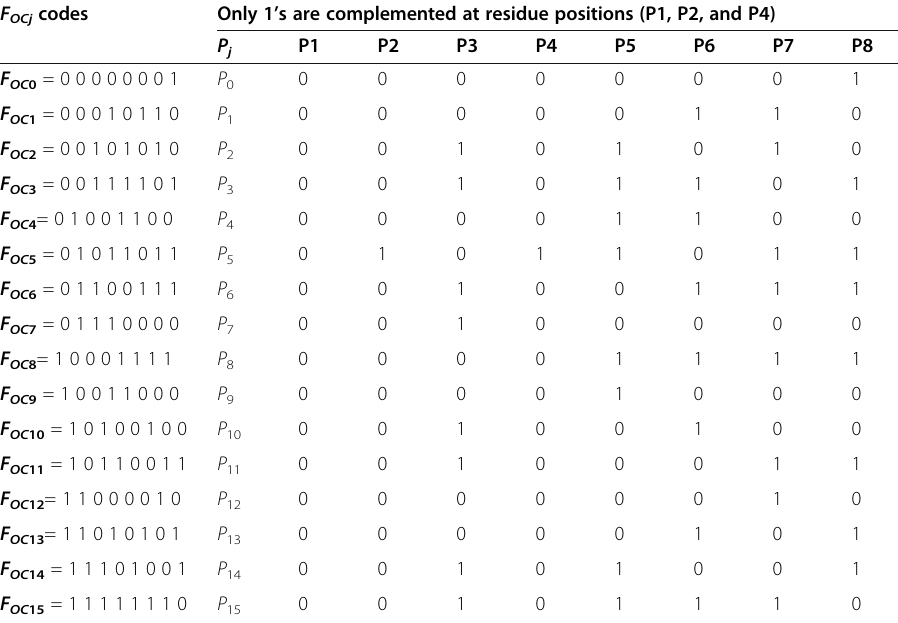
Table 4 Generation of codes ( P j ) as per step 2, case 1 F OCj codes